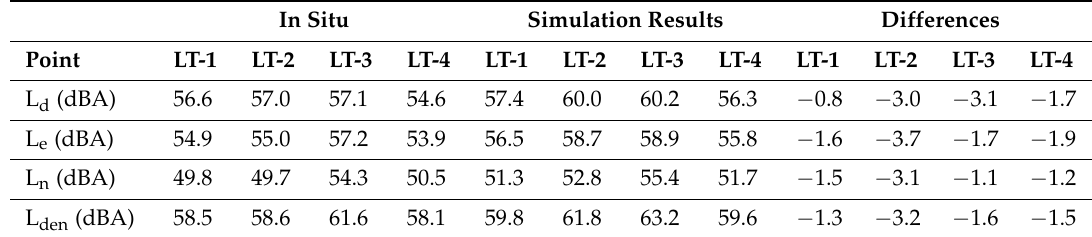
Table 4. Comparison of long-term noise levels measured and simulation results. In Situ Simulation Results Differences Point